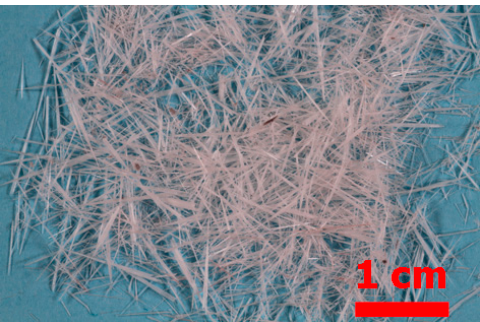
Figure 9. Visible microscopy image of the solid condensate obtained during CAS treatment at 685°C.